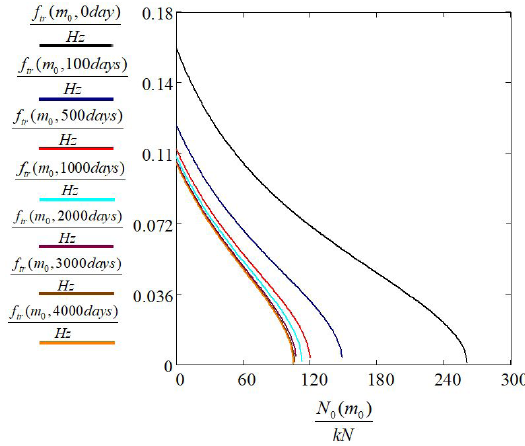
Figure 4. Results for initial condition (environmental temperature).